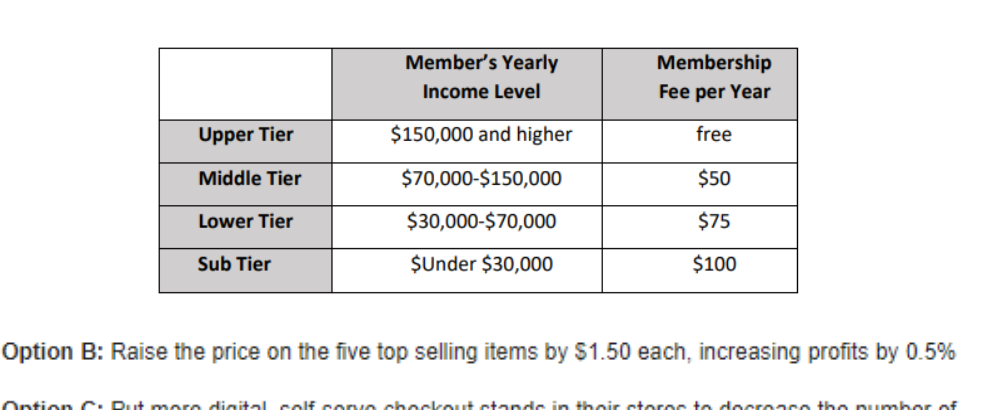
Figure 3. The Great Groceries interview task.